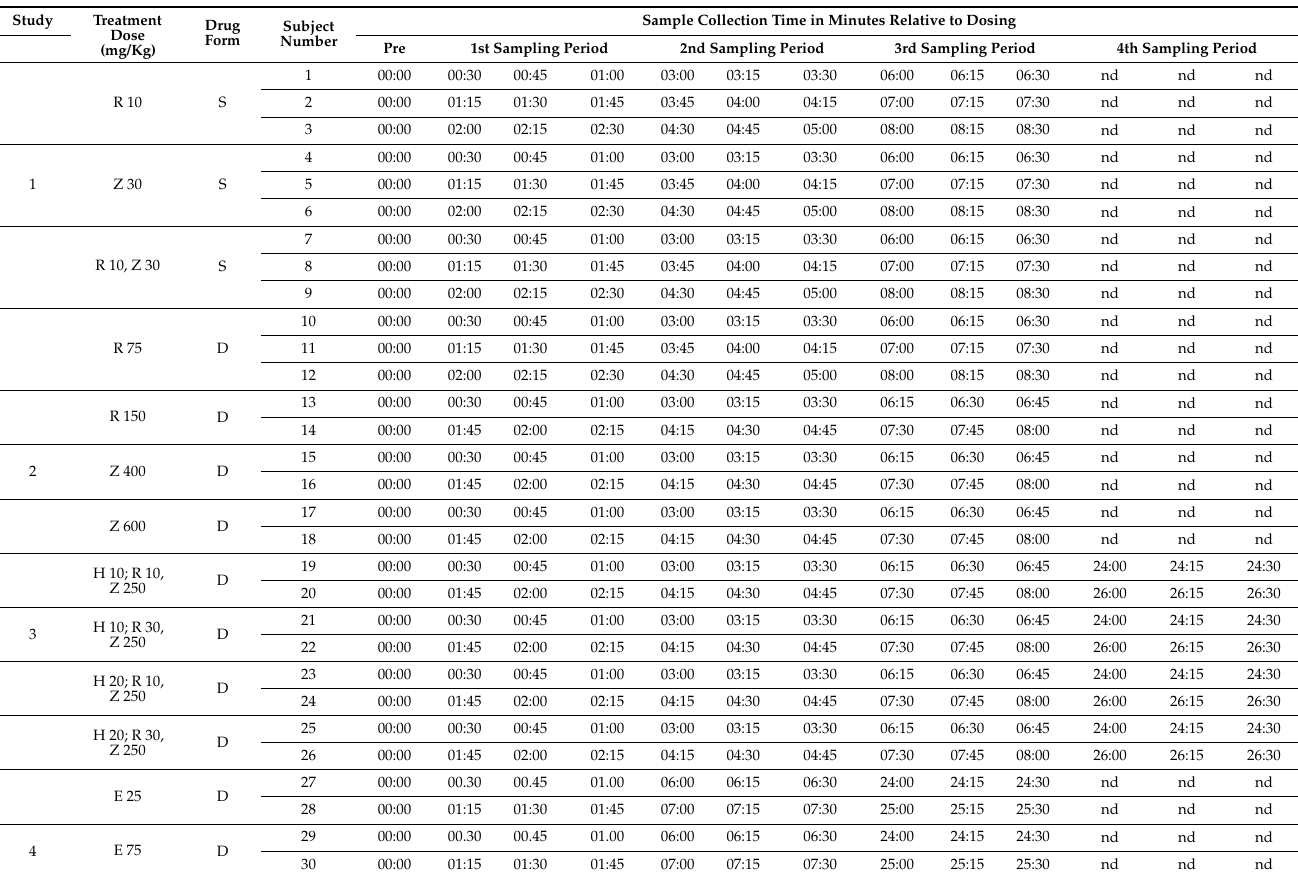
Table 1. Treatment dose and PK study blood sample collection schedule for assessment of drug pharmacokinetics in cynomolgus